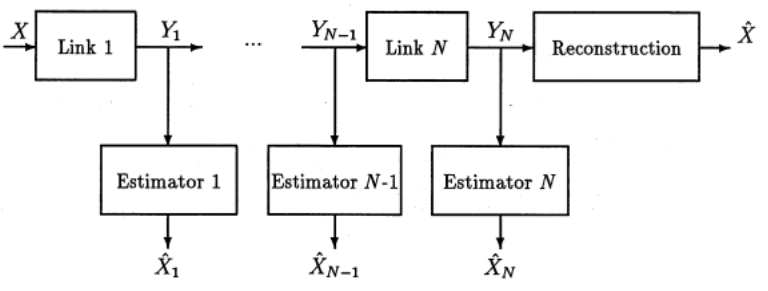
Figure 5. N-link system block diagram (adapted from